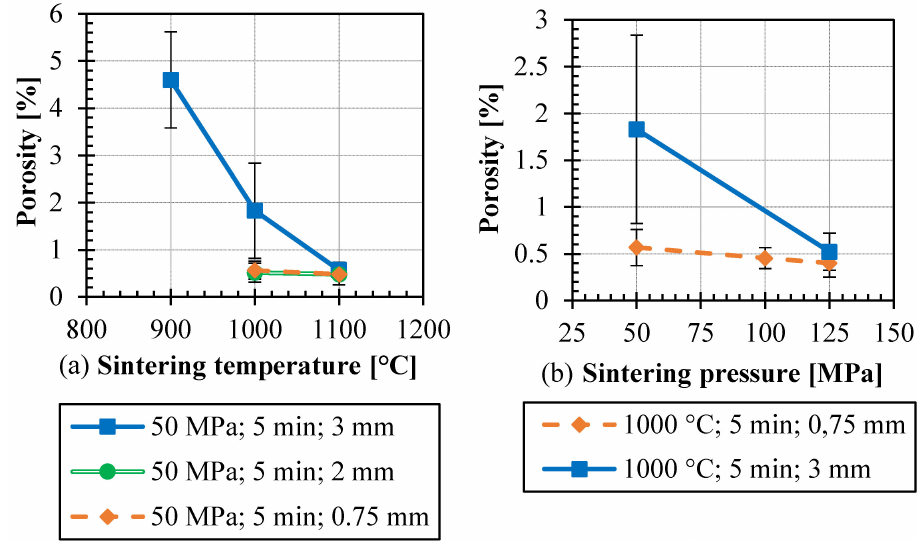
Figure 1. Residual porosity of sintered 25 W composites: ( a ) Effect of sintering temperature and consolidate’s thickness; ( b ) Effect of sintering pressure and sample thickness.